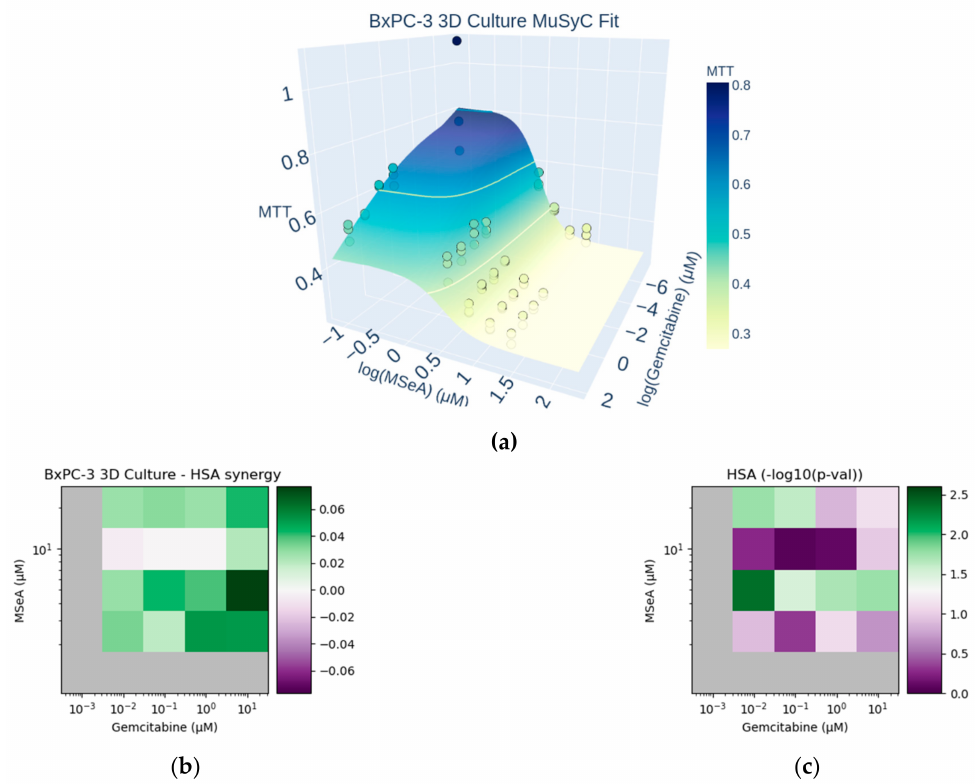
Figure 2. MuSyC and HSA synergy of Gemcitabine + MSeA in BxPC-3 cells grown in 3D culture. ( a ) Scatter points show raw response data, while the surface corresponds to the best MuSyC fit following 24 h treatments. A fully interactive version of this figure is in File S8. Best fits and 95% confidence intervals of gemcitabine and MSeA alone in 3D culture are shown in Figure S5. The MuSyC parameters used to generate this surface are given in Table S5. ( b ) Dose-dependent HSA synergy, averaged over triplicate measurements. Raw HSA values are reported in Table S6. ( c ) Statistical significance of the HSA synergy from panel ( b ), determined by two-sided, one-sample t